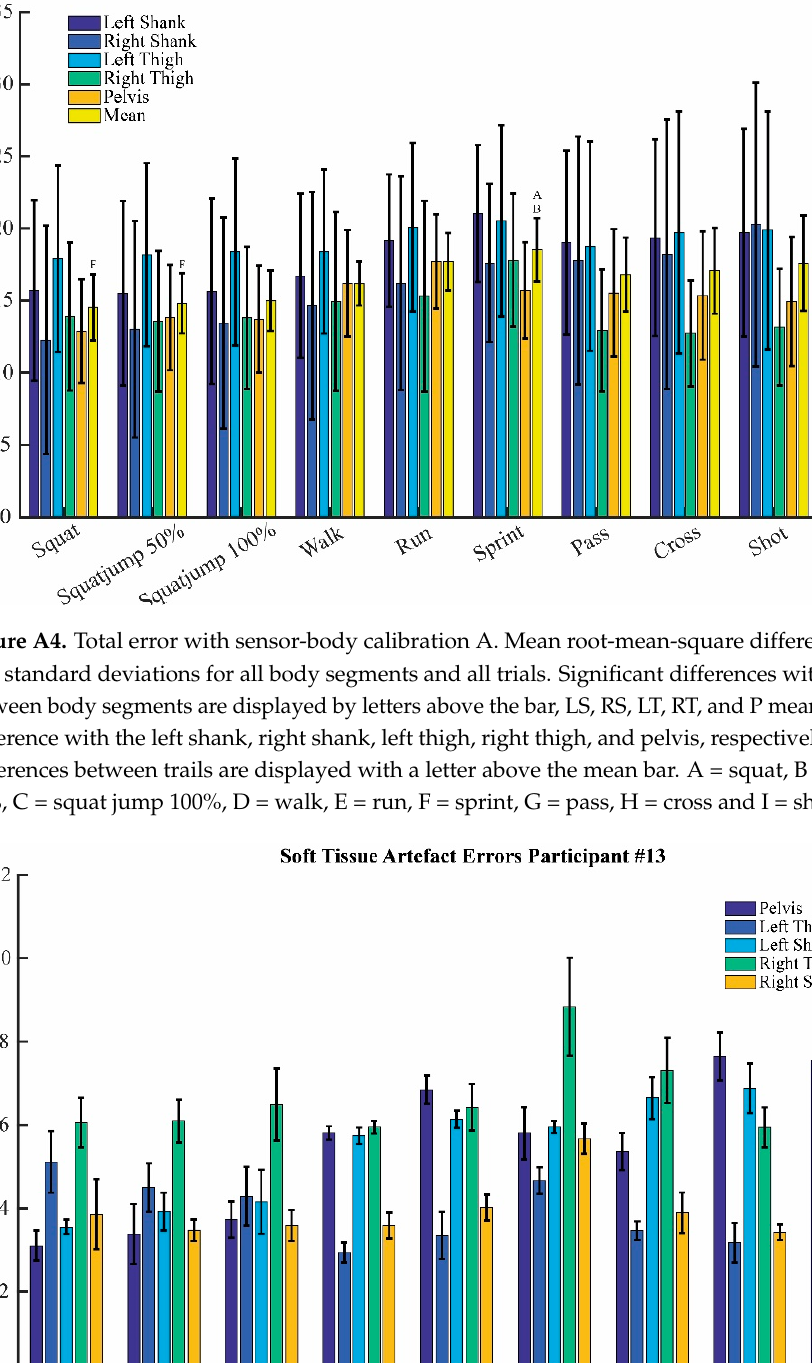
mean bar. A = squat, B = squat jump 50%, C = squat jump 100%, D = walk, E = run, F = sprint, G = pass, H = cross and I = shot.